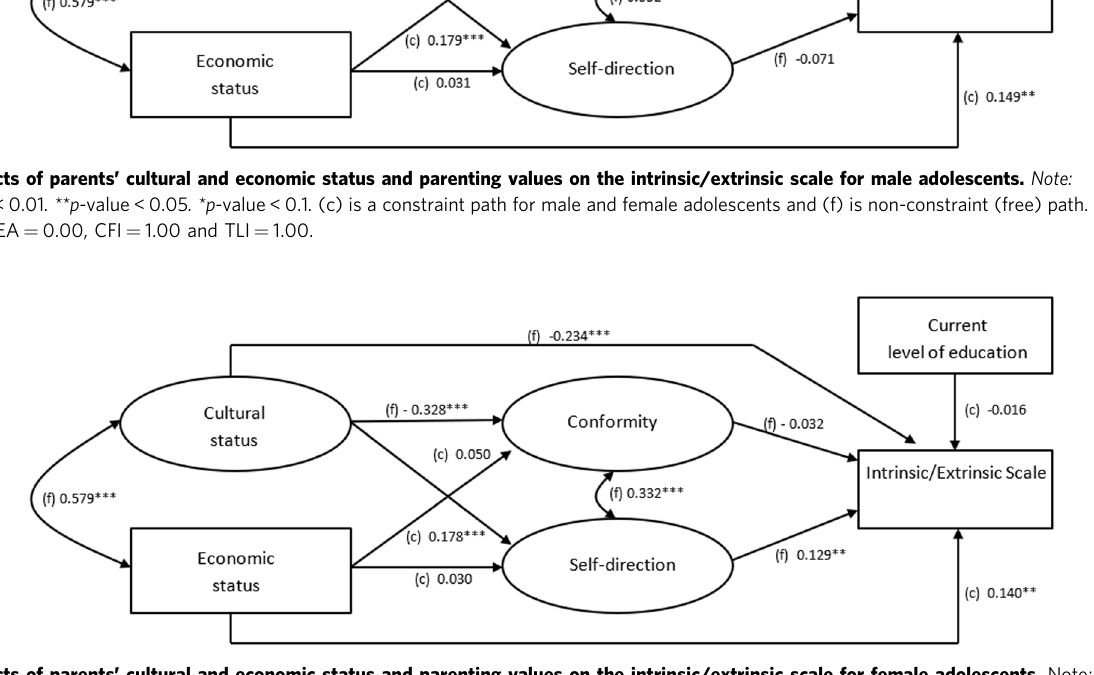
Fig. 3 Effects of parents ’ cultural and economic status and parenting values on the intrinsic/extrinsic scale for female adolescents. Note : ***p -value < 0.01 . **p -value < 0.05. *p -value < 0.1 . (c) is a constraint path for male and female adolescents and (f) is non-constraint (free) path. Goodness of fi t: RMSEA = 0.00, CFI = 1.00 and TLI =